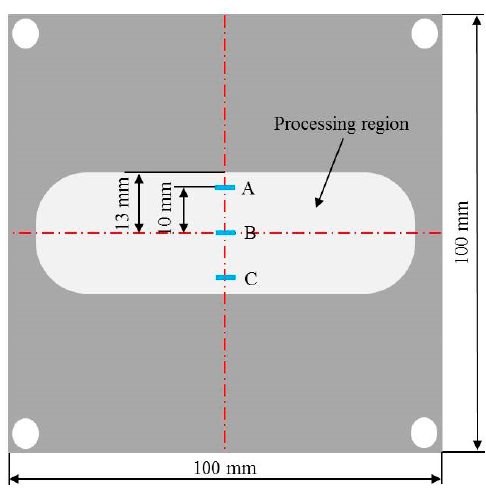
Figure 4. Observed locations of surface specimen.